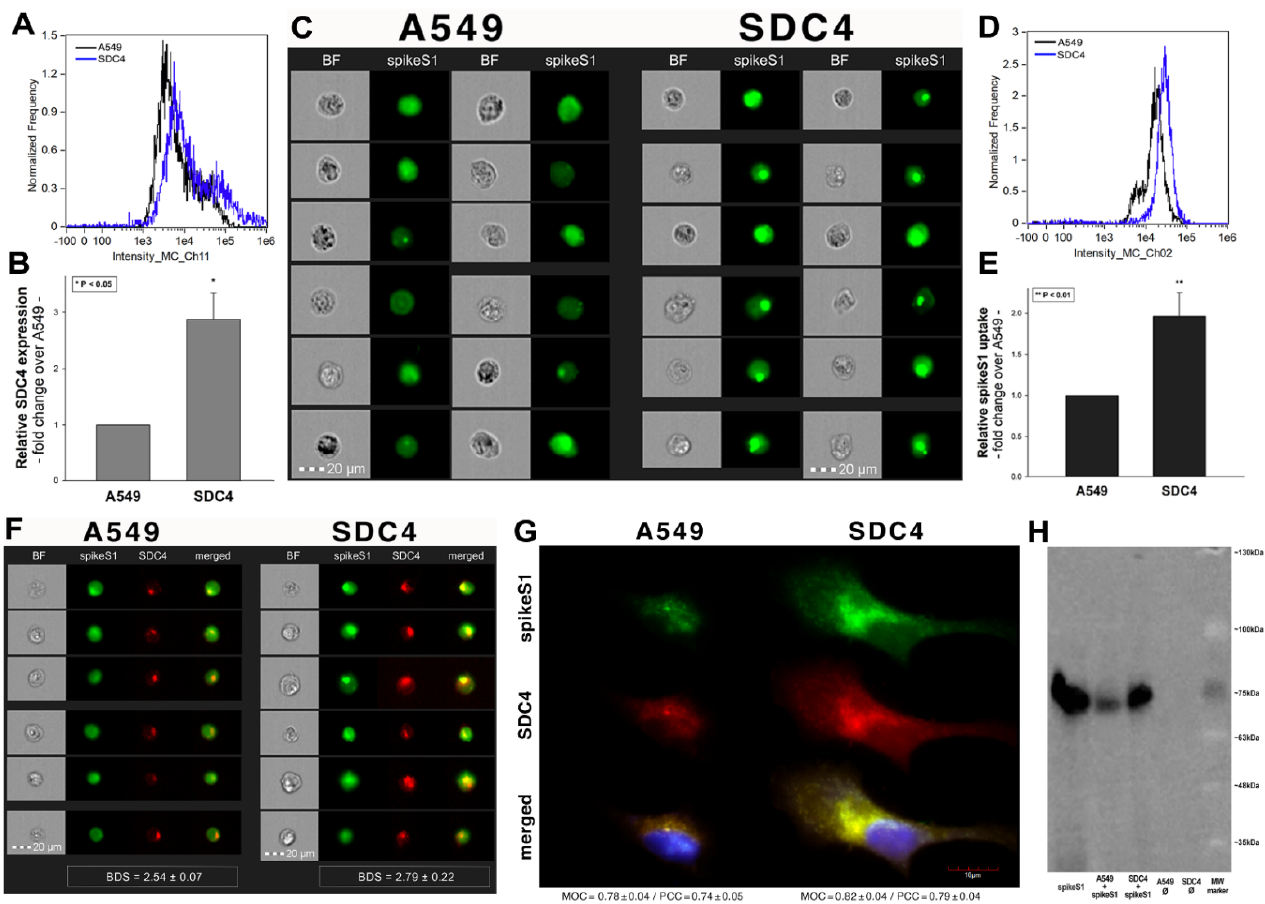
Figure 8. SDC4 overexpression increases spikeS1 uptake in A549 cells. WT A549 cells and SDC4 transfectants (created in A549 cells) were incubated with recombinant spikeS1 for 18 h at 37 °C. After incubation, spikeS1-treated cells were trypsinized, fixed, permeabilized and treated with fluorescently labeled anti-His tag antibodies. After antibody treatment, intracellular fluorescence was analyzed with either imaging flow cytometry or confocal microscopy. ( A , B ) SDC4 expression measured with flow cytometry by using APC-labeled SDC4 antibodies. ( A ) Representative flow cytometry histograms showing SDC4 expression levels of WT A549 cells and SDC4 transfectants. ( B ) Detected SDC4 expression levels were normalized to those of WT A549 cells as standards. The bars represent the mean ± SEM of three independent experiments. Statistical significance vs. standards was assessed with ANOVA. * p < 0.05. ( C ) Cellular images representing intracellular fluorescence of spikeS1-treated WT A549 cells and SDC4 transfectants. ( D , E ) SDC4 overexpression increases spikeS1 uptake. ( D ) Representative flow cytometry histograms showing the intracellular fluorescence of spikeS1-treated WT A549 cells and SDC4 transfectants. ( E ) Fold change in spikeS1 uptake following SDC4 overexpression. The bars represent the mean ± SEM of three independent experiments. Statistical significance vs. spikeS1-treated WT A549 cells as standards was assessed with ANOVA. ** p < 0.01. ( F ) Colocalization of spikeS1 in WT A549 cells and SDC4 transfectants as detected with imaging flow cytometry. The indicated BDS between spikeS1 and SDC4 represents the mean ± SEM of three independent experiments. ( G ) Confocal microscopy visualization of colocalization between spikeS1 and SDC4 in WT A549 cells and SDC4 transfectants. Representative images of three independent experiments are shown. Scale bar = 10 μm. The MOC ± SEM and PCC ± SEM for the overlap and colocalization of SDC4 with spikeS1 are indicated in the images. The MOC and PCC values were calculated by analyzing 12 images with an average of 12 cells in each image (from 3 separate samples). ( H ) A representative Western blot showing spikeS1 immunoprecipitated with SDC4 in WT A549 cells and SDC4 transfectants. Lane 1: 0.5 μg of spikeS1; lanes 2–3: immunoprecipitates of spikeS1-treated WT A549 cells and SDC4 transfectants, respectively; lanes 4–5: immunoprecipitate of WT A549 cells and SDC4 transfectants untreated with spikeS1 (controls). Standard protein size markers are indicated on the right.